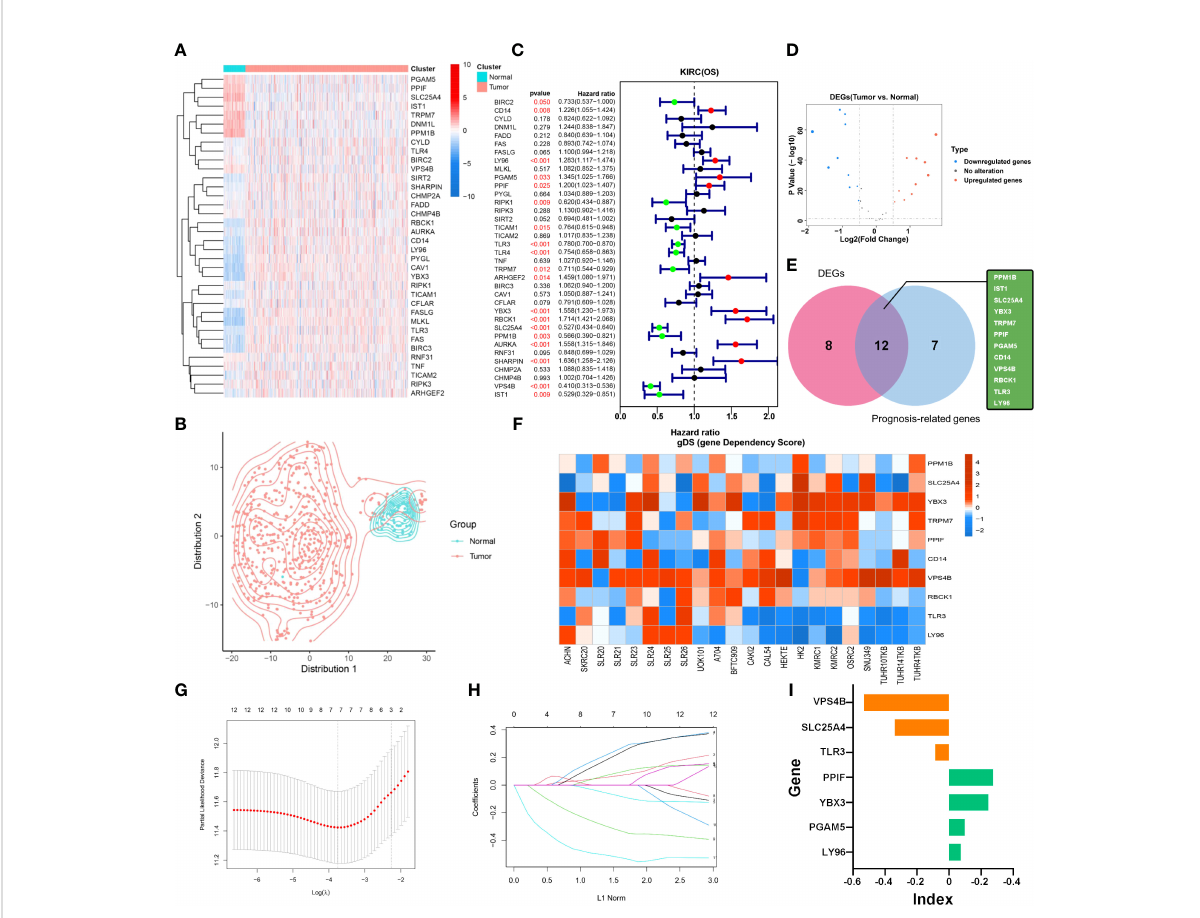
FIGURE 2 Identi fi cation of NPRGss and NPRGs risk signature. (A) Heatmap showing the expression of necroptotic-process-related genes. (B) The t-SNE analysis in tumor and normal groups. (C) The forest plots were depicted to show the prognosis-related genes determined by the univariate Cox regression analysis. (D) The volcano fi gure shows the necroptotic-process-related DEGs. (E) Venn diagram showing the overlapping NPRGss. (F) Heatmap showing the gDS (gene dependency score) of NPRGss in a renal cancer cell. (G, H) LASSO regression analyses of NPRGss using the OS model. (I) The bar chart displays LASSO regression coef fi cients of the